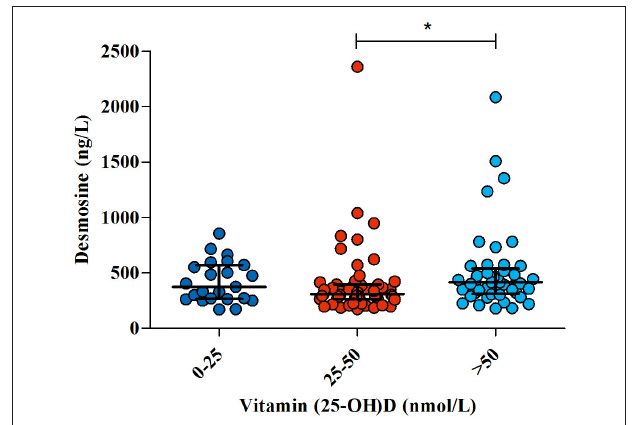
FIGURE 2 | The association between 25(OH) vitamin D status and elastic fiber degradation. In 122 COVID-19 patients, 25(OH) vitamin D and desmosine were measured as a marker of elastic fiber degradation. Three hemodialysis patients were excluded from the analysis. Patients were split up based on vitamin D status. Lines and error bars represent median and interquartile range. * Significant difference was found in desmosine levels in patients with vitamin D insufficiency compared to sufficient